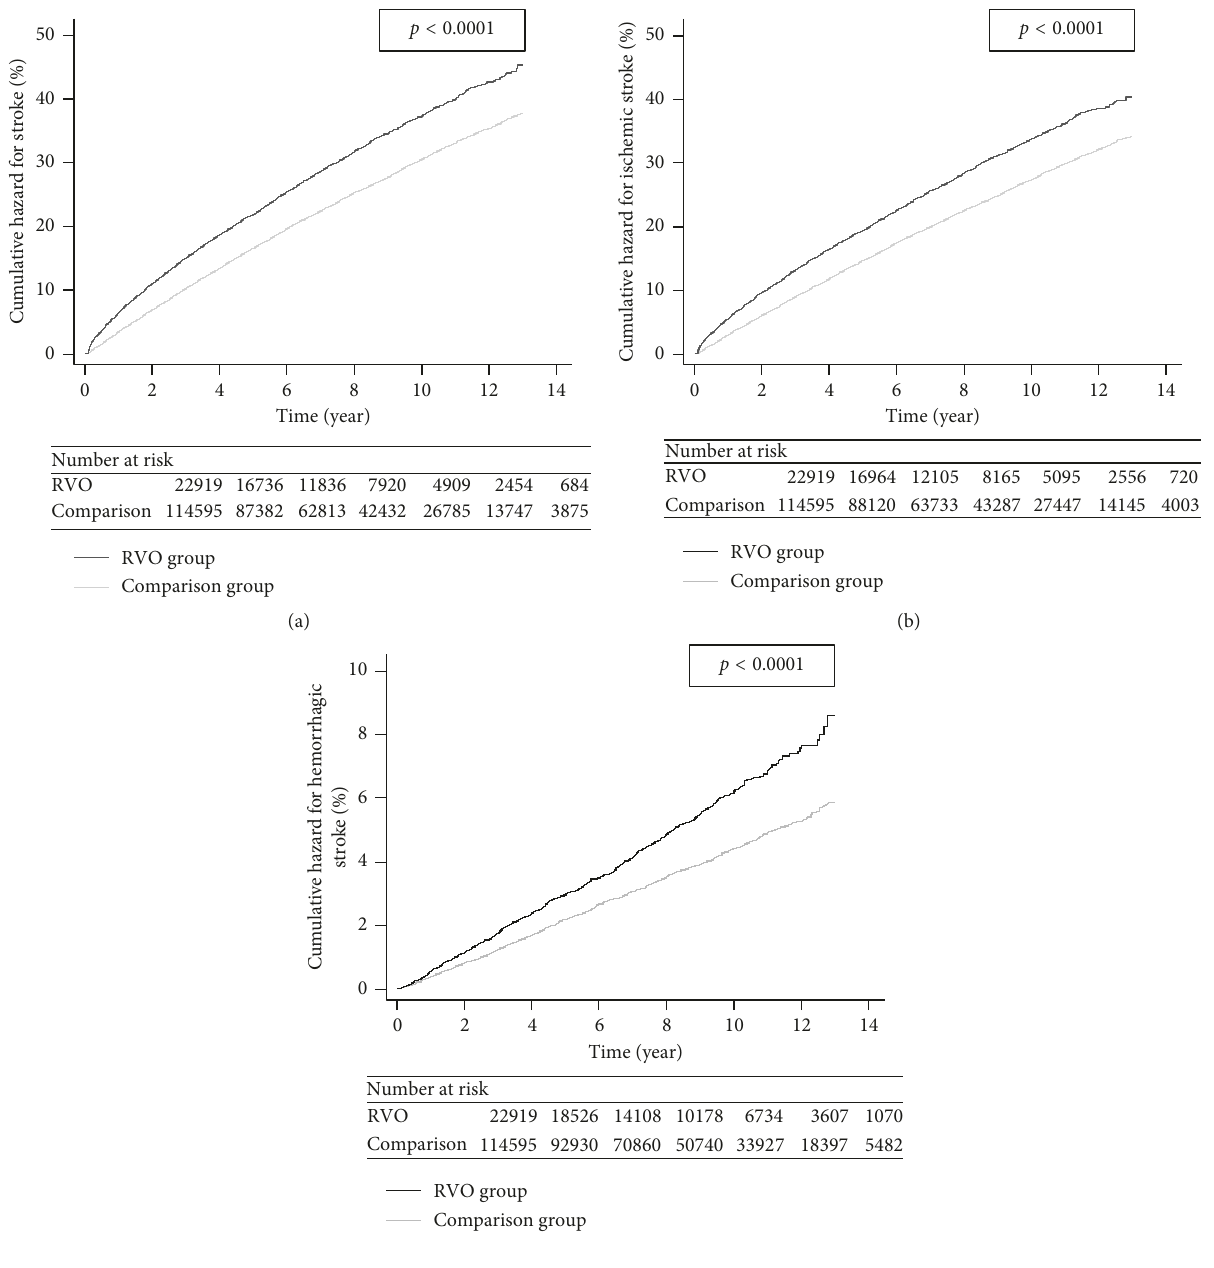
Figure 1: Kaplan–Meier curves for (a) stroke, (b) ischemic stroke, and (c) hemorrhagic stroke in the RVO and the PS-matched comparison groups. The black line represents the RVO group, and the gray line represents the comparison group. RVO: retinal vein